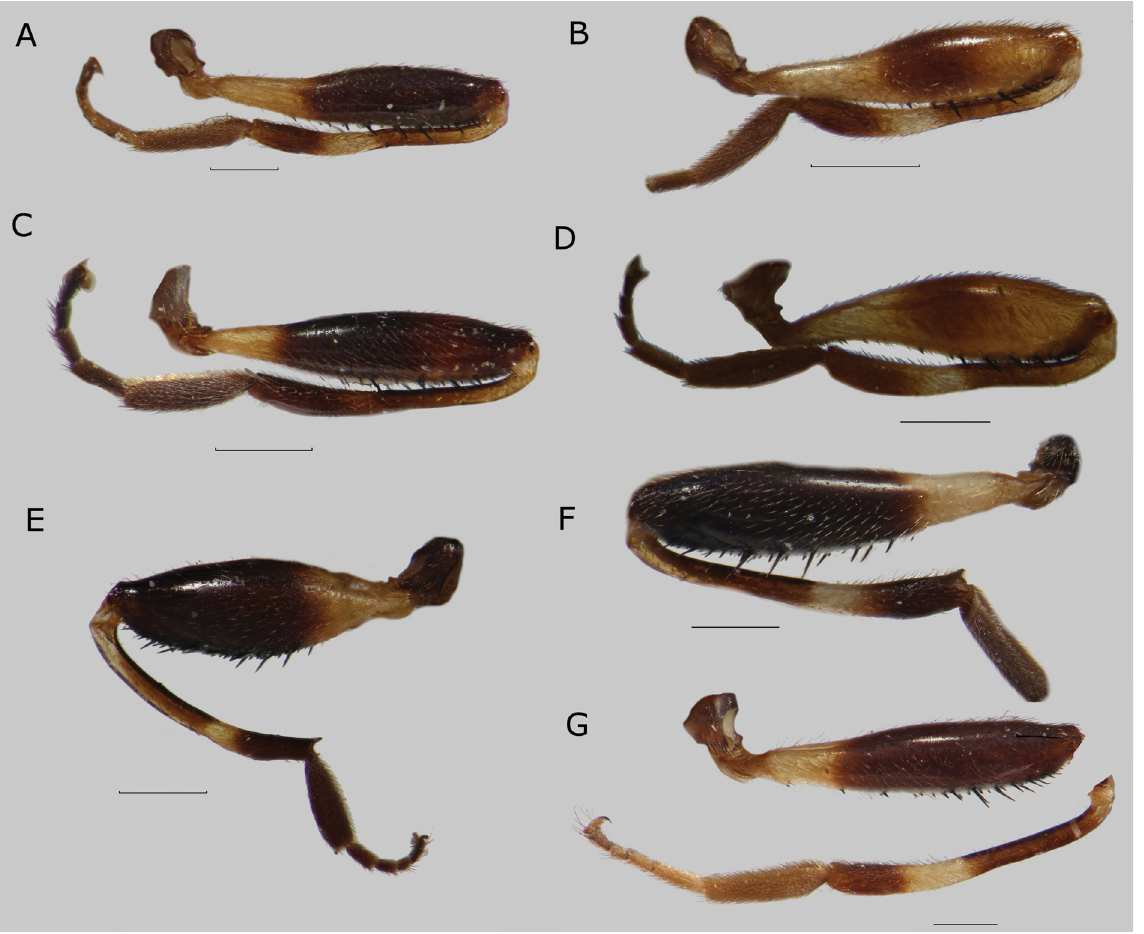
Fig. 33. Metaleg, anterior view. A . Sphegina (Asiosphegina) crassispina Hippa, van Steenis & Mutin, 2015, paratype, ♀ , Myanmar. B . S. ( A. ) crucivena Hippa, van Steenis & Mutin, 2015, paratype, ♂ , Myanmar. C . S. (A.) exilipes sp. nov., holotype, ♂ , Java. D . S. (A.) for fi cata Hippa, van Steenis & Mutin, 2015, paratype, ♂ , Myanmar. E . S. (A.) ghatsi sp. nov., holotype, ♂ , India. F . S. (A.) gigantea sp. nov., holotype, ♂ , China. G . S. (A.) gigas Hippa, van Steenis & Mutin, 2015, paratype, ♀ , Myanmar. Scale bars = 0.5